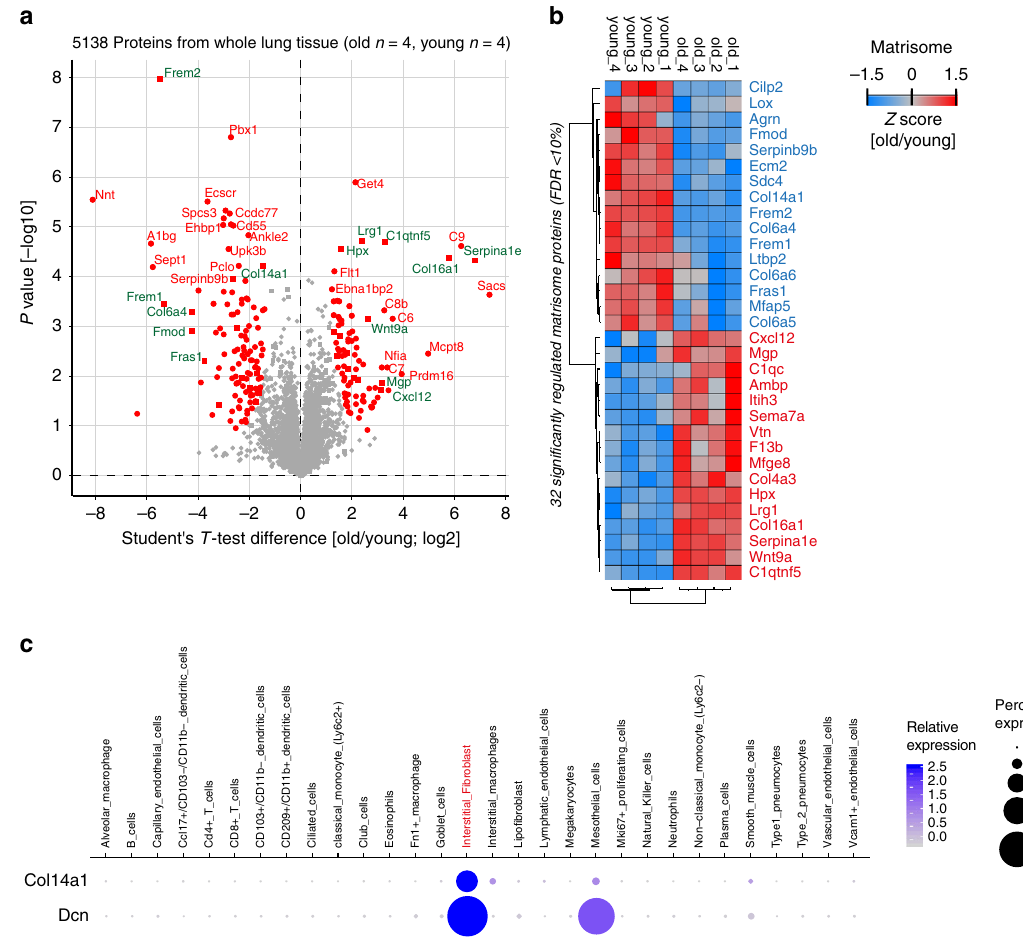
Fig. 5 Single-cell RNA-sequencing (scRNA-seq) predicts cellular origin of age-dependent protein alterations. a Proteins regulated with a false discovery rate < 10% are highlighted in red in the volcano plot showing the indicated fold changes and p values derived from t -test statistic. Matrisome proteins are labeled with green gene names. b The z -score values of 32 signi fi cantly regulated extracellular matrix proteins were grouped by unsupervised hierarchical clustering (Pearson's correlation). c The dot plot shows mRNA expression speci fi city of Col14a1 and its binding partner Decorin ( Dcn ) in the scRNA-seq